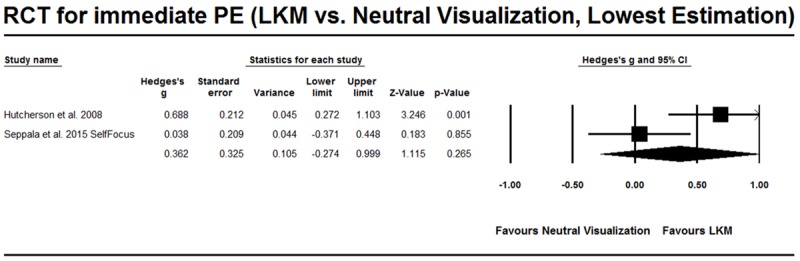
RCT studies for PE from on-going practice, comparison with neutral visualization. The lowest estimation was based on self-focused positive emotion (SelfFocus) in Seppala et al. (2014).